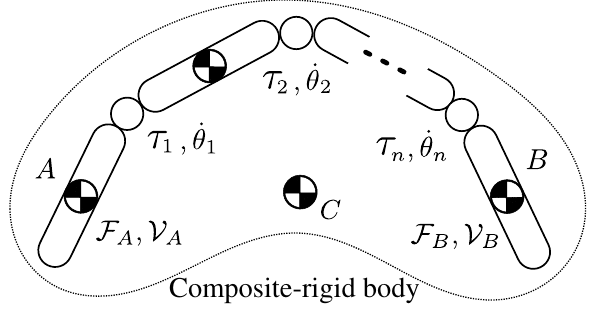
Figure 8. Model of a unfixed-base serial-link chain. The system constitutes a single composite rigid body, C denoting its